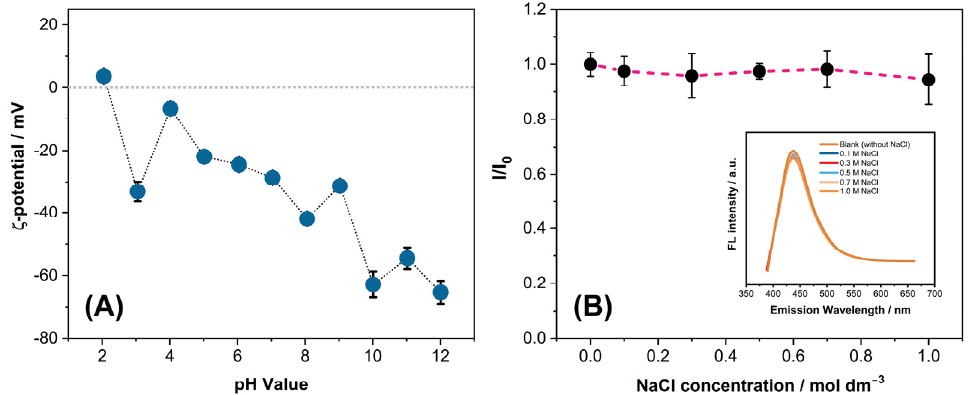
Figure 3. CQD@Leu stability studied by ( A ) variations of ζ -potential as a function of pH) and ( B ) in the high ionic medium of NaCl (0–1.0 mol dm − 3 ).